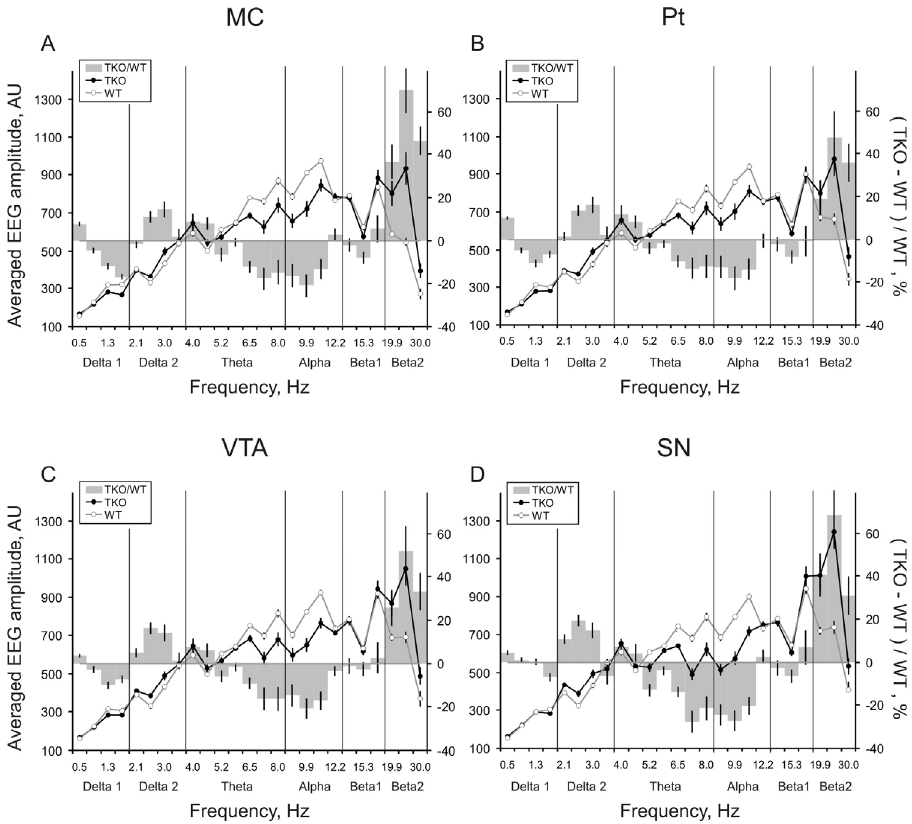
Figure 2. Averaged baseline EEG spectra in triple-knockout mice vs. wild-type littermates. Averaged amplitude-frequency spectra of 12 s baseline EEG fragments recorded from the motor cortex ( A ), putamen ( B ), VTA ( C ) and SN ( D ) for 30 min in wild-type (WT, n = 10) and triple ( alpha-, beta-, and gamma- synucleins) knockout (TKO, n = 8) mice (dashed and solid lines, respectively) and spectral ratios (grey bars) between the groups (TKO/WT) in %. Abscissa is a frequency sub-band marked with its mean value, in hertz; the left ordinate is summed absolute values of EEG amplitudes in each of 20 sub-bands, normalised to sum of all amplitude values, in arbitrary units; and the right ordinate is a ratio of the EEG amplitudes, calculated as (TKO-WT) / WT, in %. Vertical lines are ± 1 SEM. Vertical grey lines separate “classical” EEG frequency bands: delta 1 , delta 2, theta , alpha , beta 1 , and beta 2 .